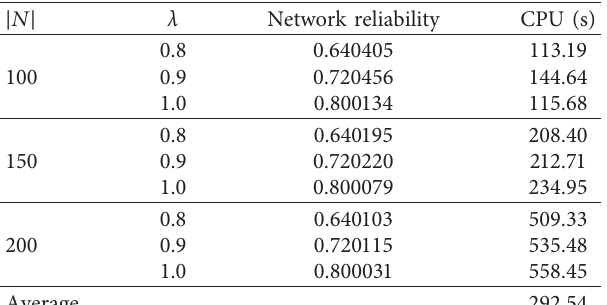
Table 7: Computational results for the large-scale URAND